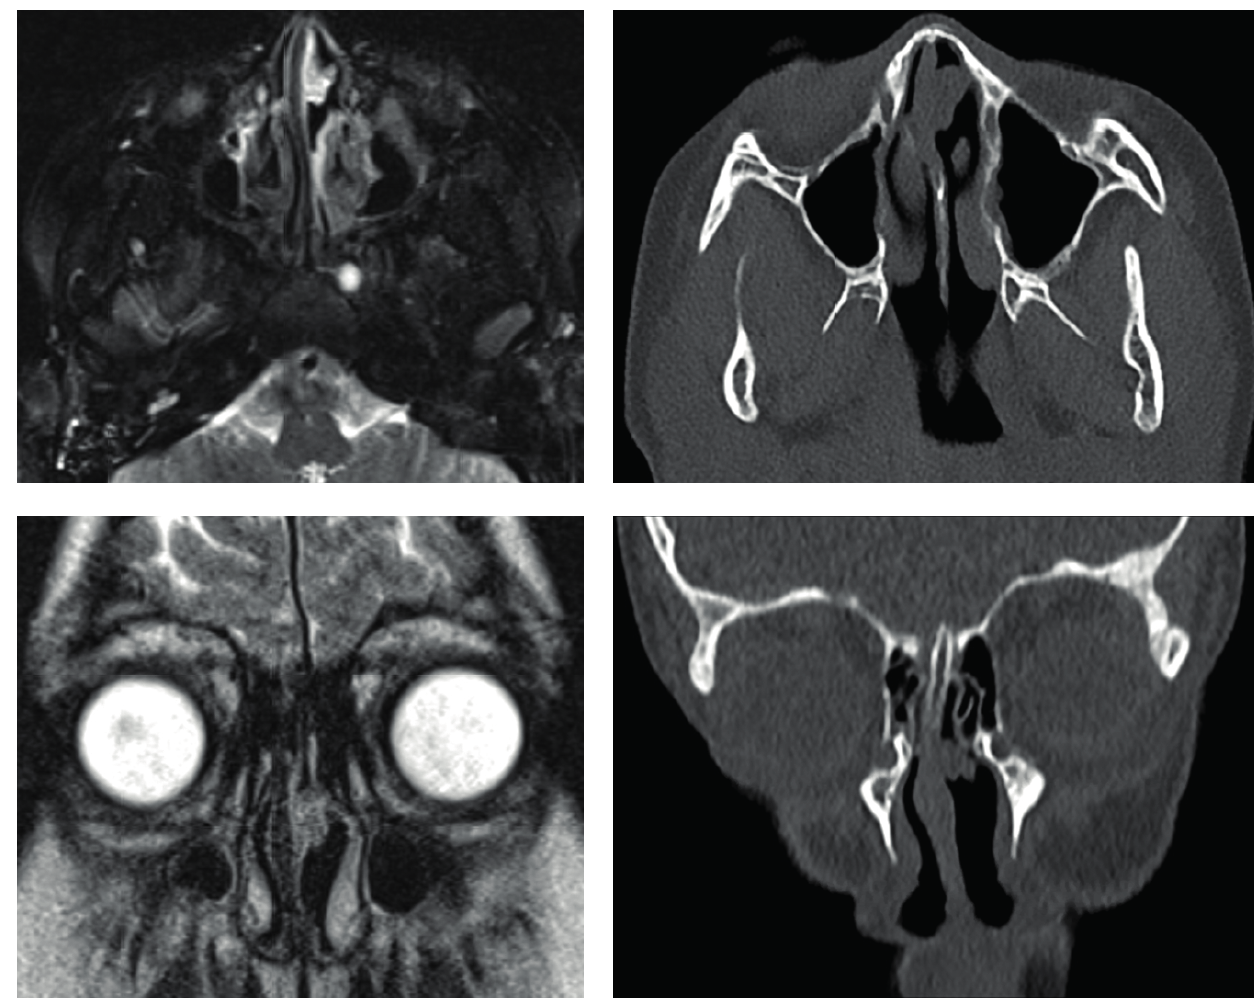
Figure 1. Axial and coronal views of T2-weighted MRI and non-contrast CT images of the left nasal